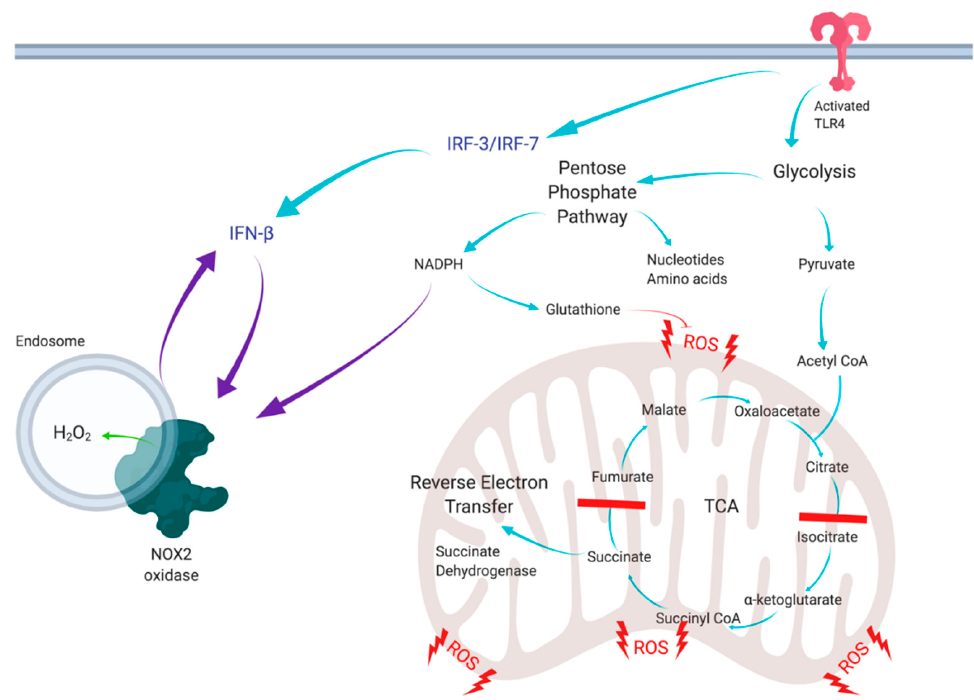
Figure 6. Schematic of mechanisms of the metabolic switch in response to macrophage activation by LPS. Activation induces the metabolic switch, which upregulates glycolysis and the PPP, breaking the TCA cycle and causing a switch from oxidative phosphorylation to reverse electron transfer to generate mitochondrial ROS. Upregulation of glycolysis and the PPP causes release of IFN- β , which is involved in an intricate feedback loop, via increased activation of NOX2 oxidase. NOX2 oxidase, in turn, can increase the production of IFN- β . Blue arrows represent the current literature, and purple arrows represent the novel concepts of this study, including the positive feedback loop. Created with BioRender.com (accessed on 21 March 2022).